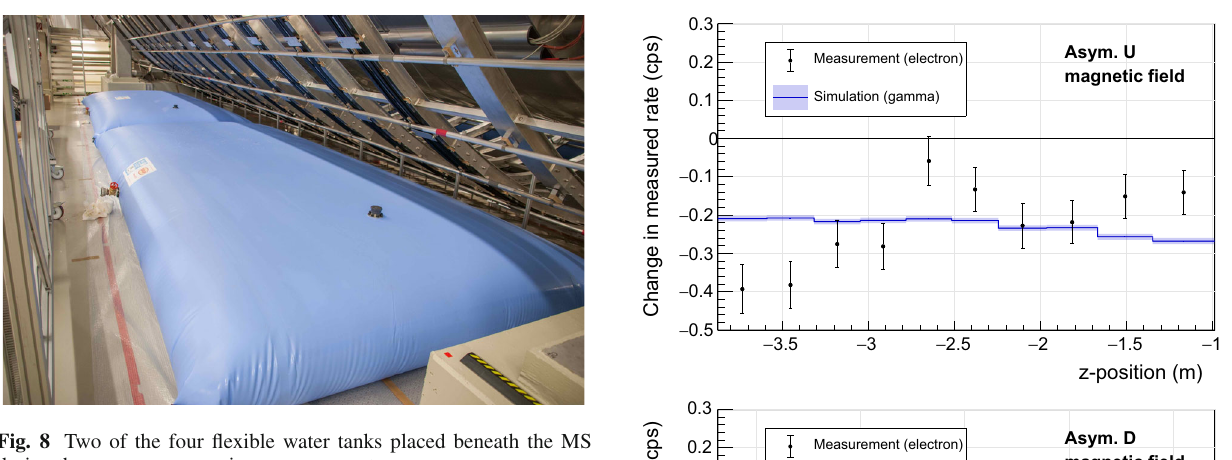
Table 6 Results from the FPD measurements with(out) the water shielding. “Asym. U” and “Asym. D” indicate that the asymmetric mag- netic field images the upstream ( z = − 3 . 9 m to − 1 . 0 m) and down- stream ( z = 1 . 3 m to 3.7 m) region of the MS surface, respectively (see